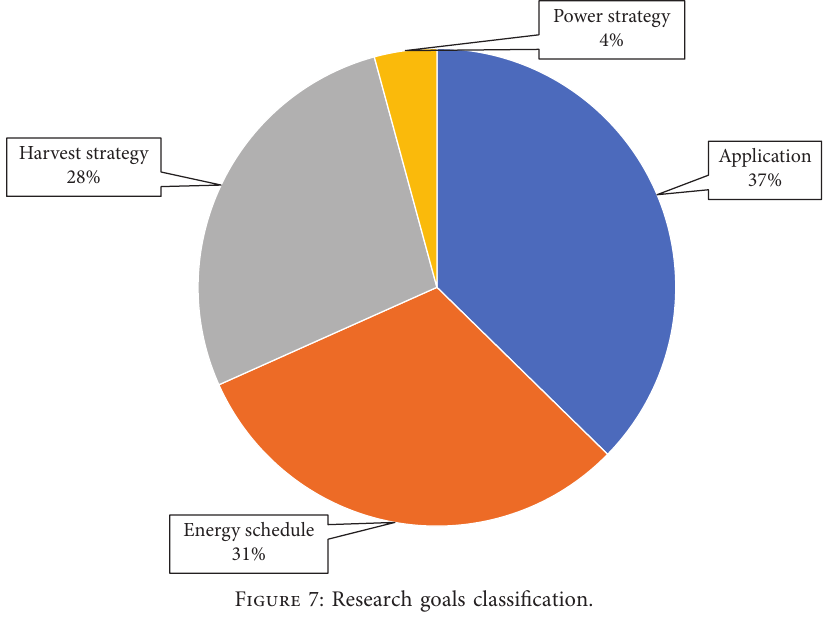
Figure 7: Research goals classification.